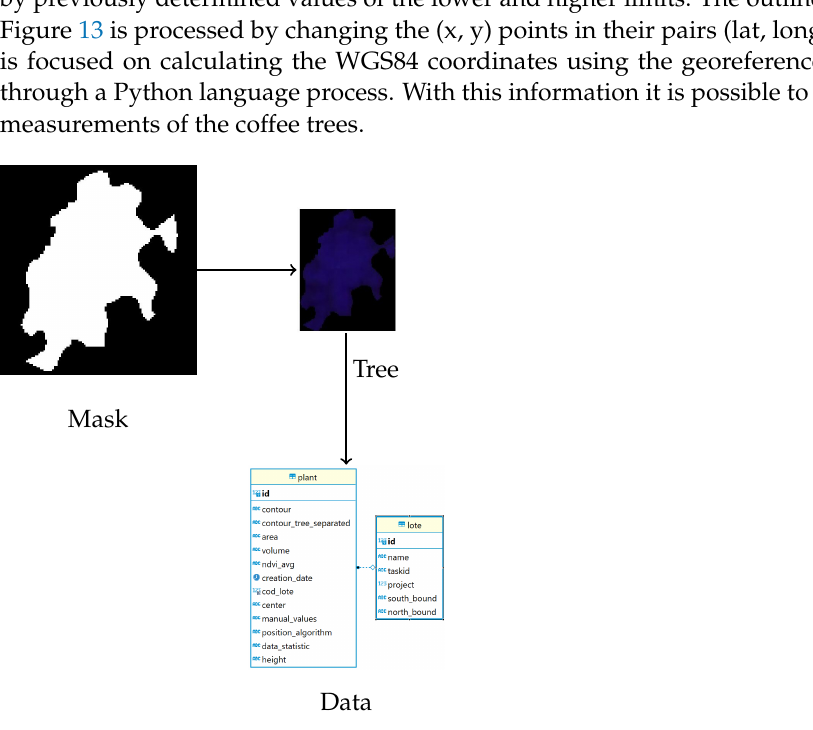
Figure 13. Extraction variables flow: the mask corresponds to the detection of the tree. The mask is applied to the RGB three-band image to extract the data and store it in the Mysql relational